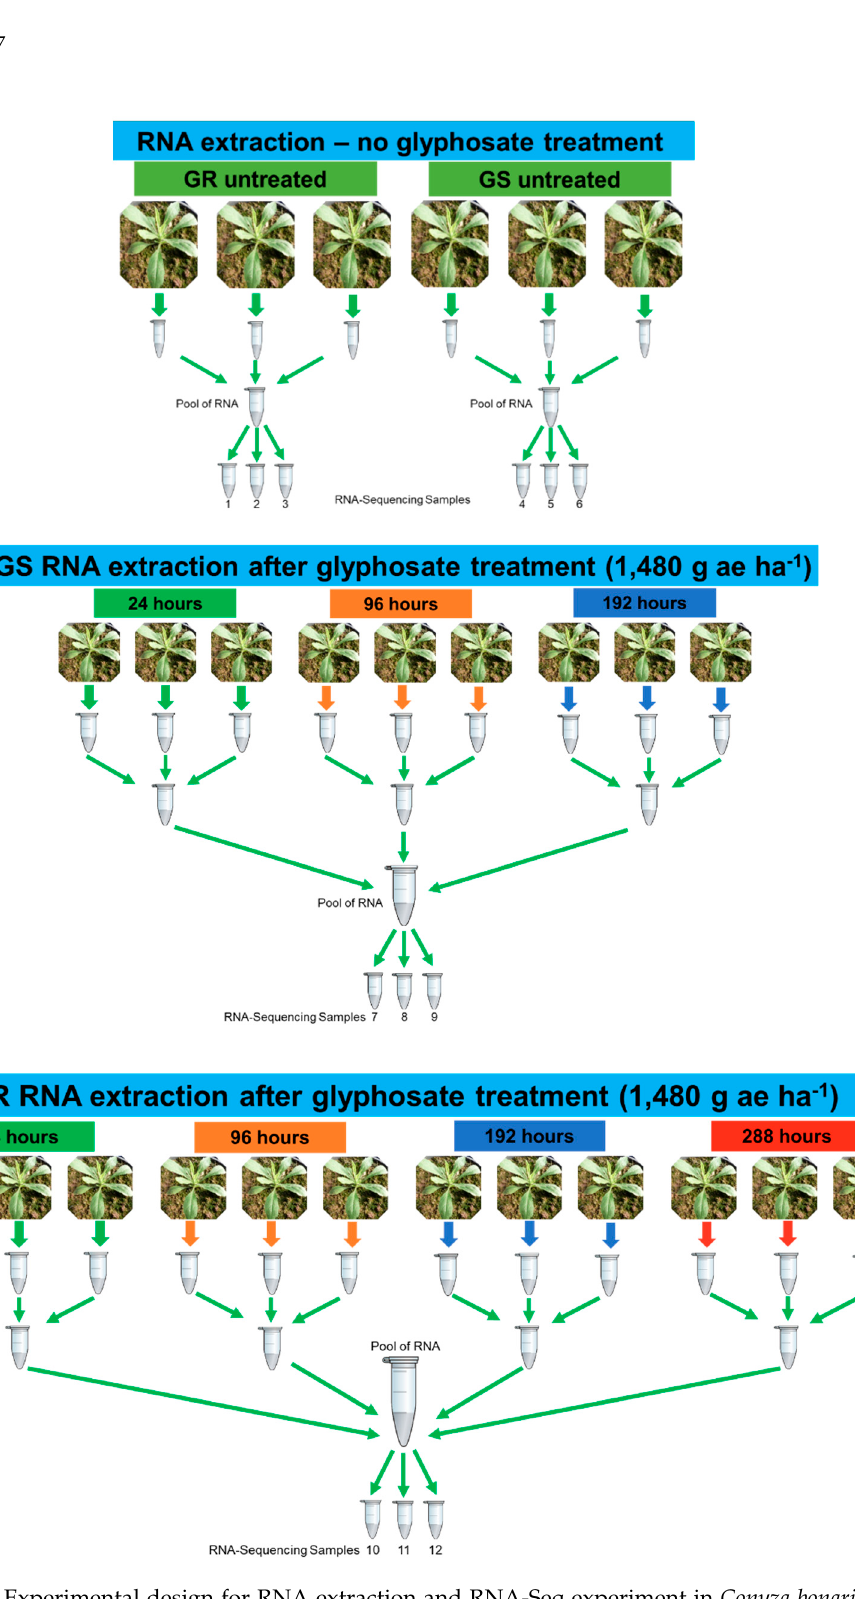
Figure 9. Experimental design for RNA extraction and RNA-Seq experiment in Conyza bonariensis glyphosate-resistant (GR) and -sensitive (GS) biotypes with (t1) and without (t0) glyphosate treatment. RNA samples 1–3: GR t0—untreated; RNA samples 4–6: GS t0—untreated; RNA samples 7–9: GS t1—RNA samples extracted at 24, 96, and 192 h after glyphosate treatment; RNA samples 10–12: GR t1—RNA extracted at 24, 96, 192, and 288 h after glyphosate treatment. RNA was extracted from a total of 27 plants and pooled according to each treatment. Three technical replicates were sequenced from each treatment (GR t0, GS t0, GS t1, and GR t1—a total of 12 libraries). Glyphosate rate of 1480 g ae ha − 1